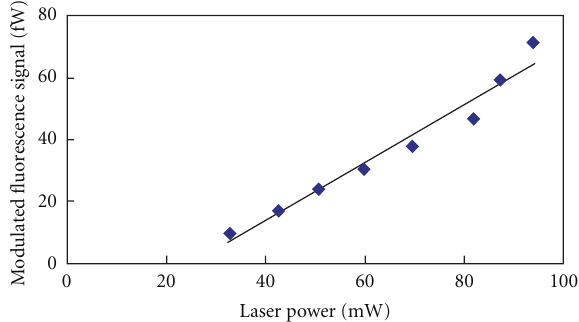
Figure 5: Excitation laser power versus modulated fluorescence signal quantified by the spectrum